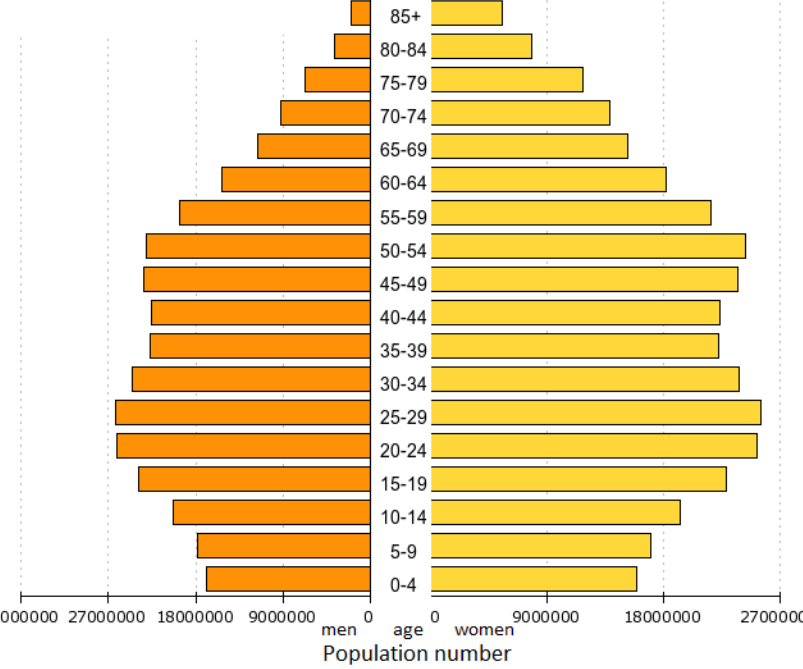
Figure 1. The number of cancer cases in Poland in the years 1999–2015 (age pyramid). Source: National Cancer Registry [10].